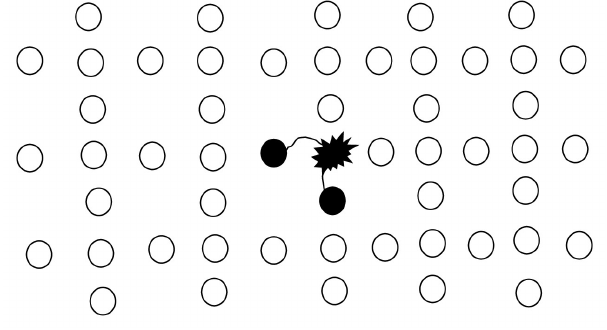
Figure 3: At each step of plasmodium propagation, there are not more than four attractants which can be occupied. At the first time step the plasmodium expansion is coded by the 5-adic integer . . .